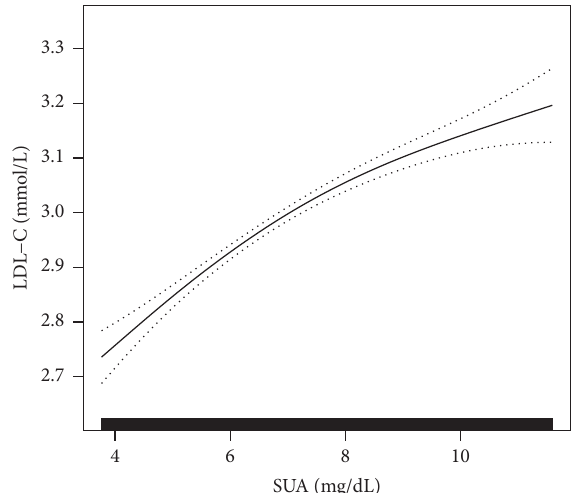
Figure 2: The positive association between SUA and LDL-C in a hypertensive population. Adjusted for age, sex, smoking, alcohol use, stroke, diabetes, antihypertensive drugs, lipid-lowering drugs, glucose-lowering drugs, BMI, SBP, DBP, Hcy, FBG, and